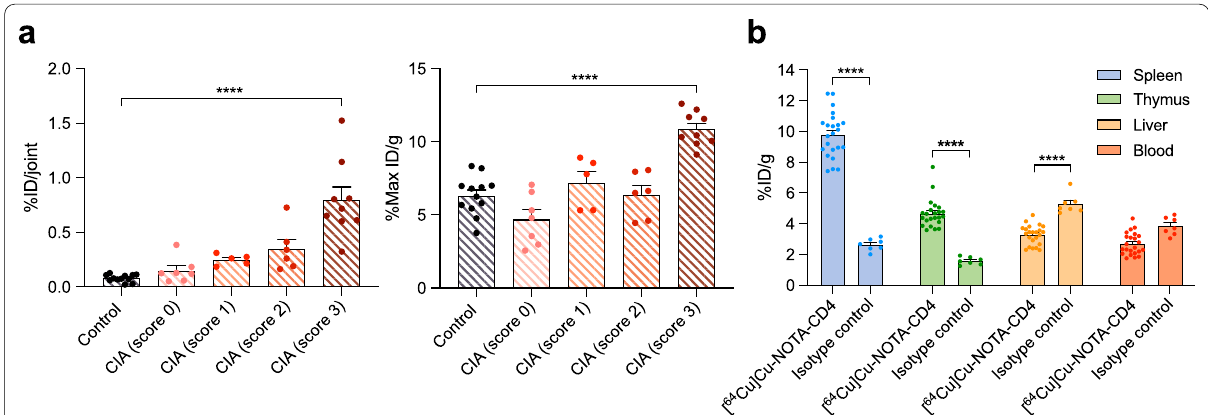
Fig. 5 Isotype control uptake on PET images of collagen-induced arthritis (CIA) mice. a [ 64 Cu]Cu-NOTA-IgG2b imaging 24 h p.i. of the carpal and tarsal joints of control ( n 6) and CIA mice ( n 8). Tracer accumulation is calculated as %ID/joint and %Max ID/g. Each point represents a joint. b = = Comparison of [ 64 Cu]Cu-NOTA-CD4 ( n 23) and isotype control, [ 64 Cu]Cu-NOTA-IgG2b ( n 7) uptake in spleen, thymus, liver and blood of CIA mice = = expressed as %ID/g. Data are presented as mean SEM. The significance level is indicated by asterisks (*). p < 0.0001 ±